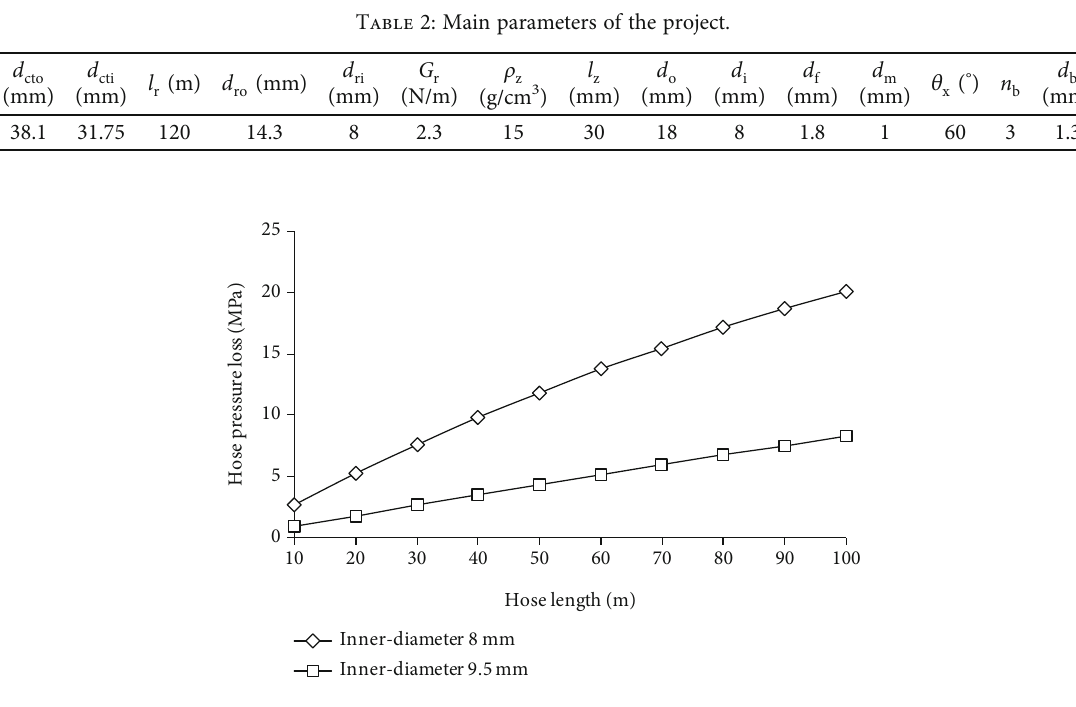
Figure 3: Hose pressure loss in fl uenced by the hose